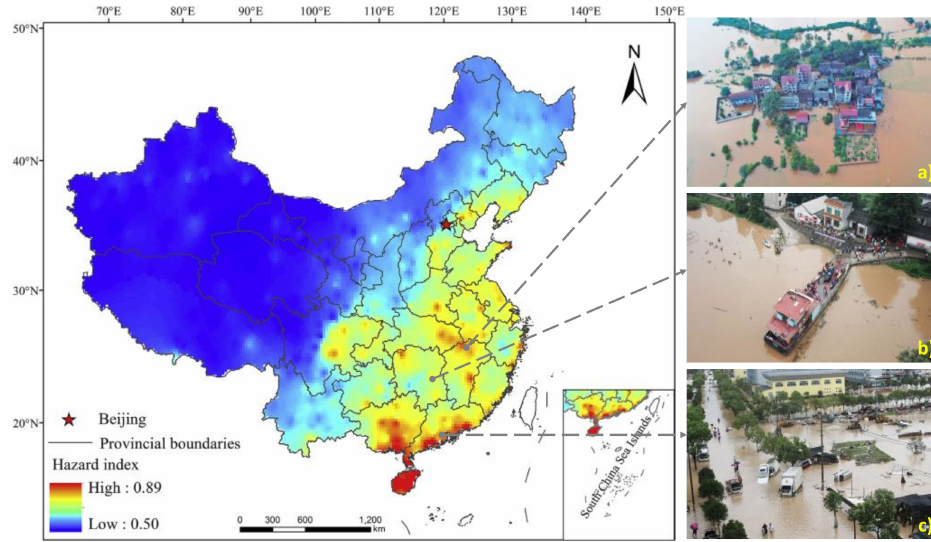
Figure 1. The central panel shows the flood hazard index over China (after [25]). ( a ) Submerged neighborhood in Jiangxi province ( credits: REUTERS); ( b ) high water level rise in Changsha, Hunan province ( credits: Xinhua); and ( c ) Dajing city, Zhejiang province under floods, August 2019 ( credits: